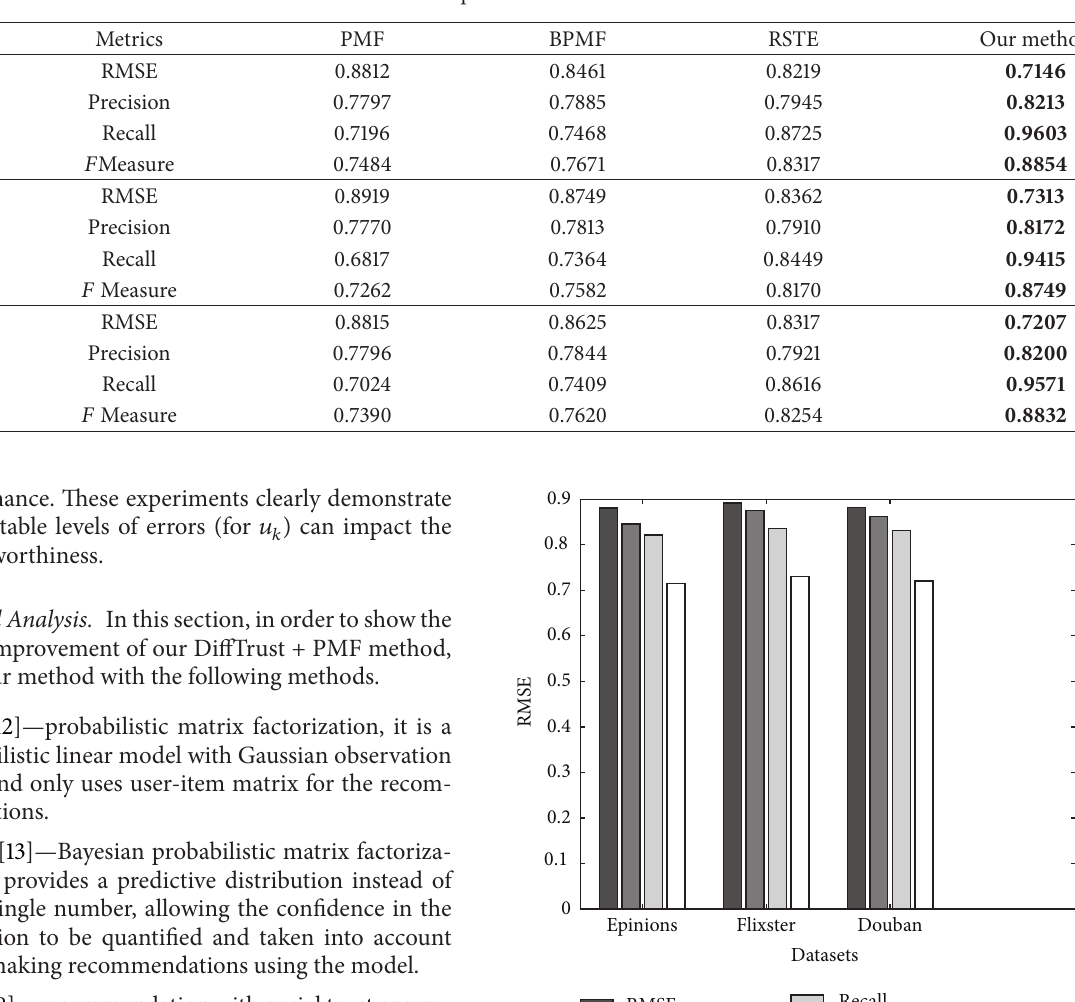
Table 3: Shows all comparisons on three datasets.